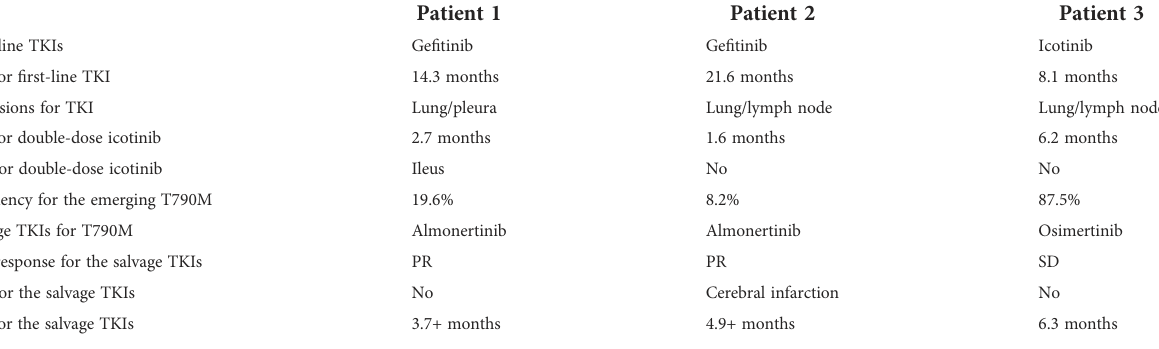
TABLE 2 Procedure, ef fi cacy, and safety assessment of treatment for the patients.